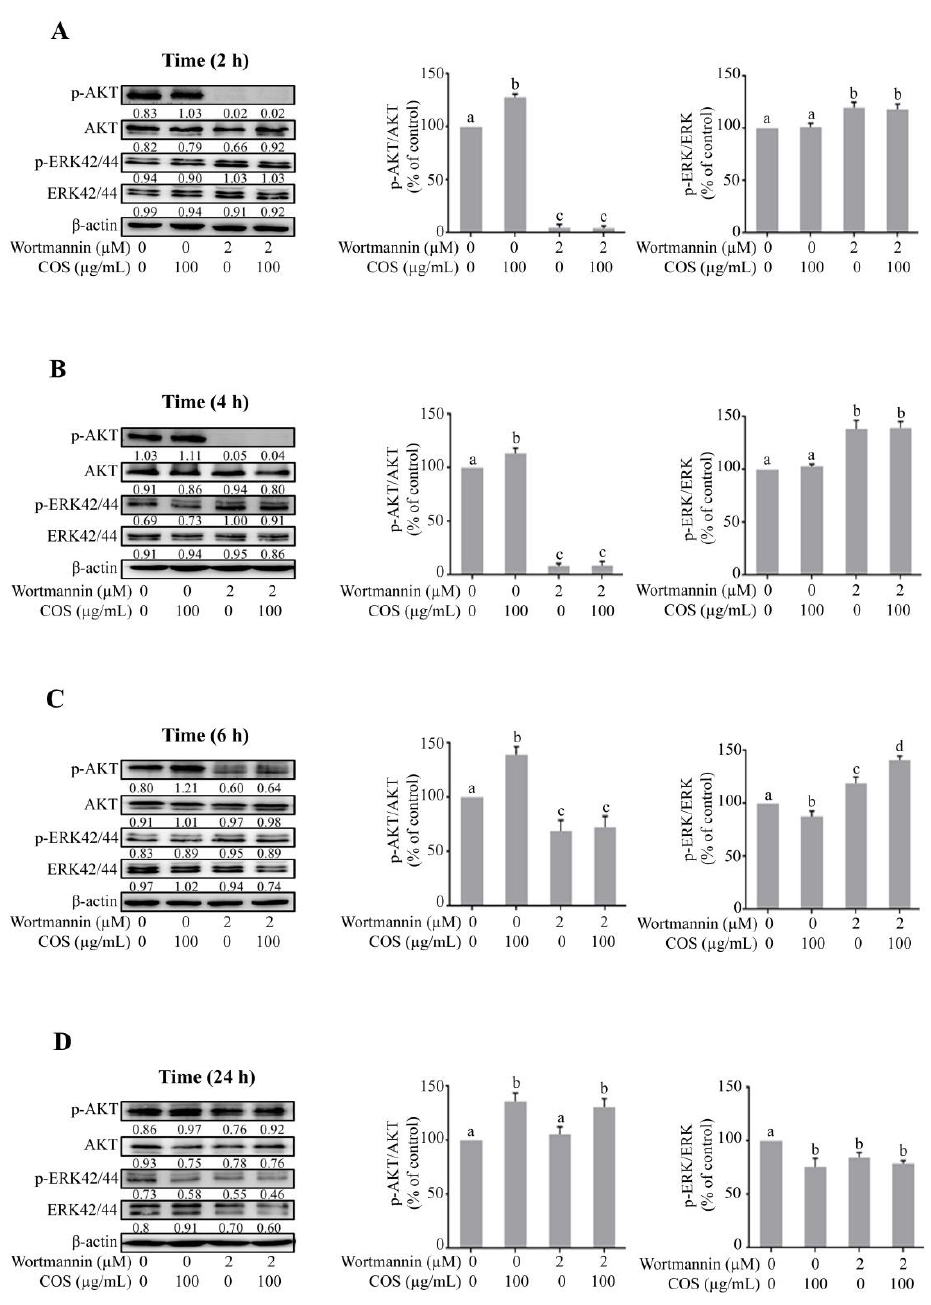
Figure 4. Effect of COS on AKT and ERK phosphorylation studied using wortmannin. ( A ) T84 cells were treated with the indicated concentrations of COS, wortmannin, either alone or in combination for 2 h ( A ), 4 h ( B ), 6 h ( C ), and 24 h ( D ). Data were analyzed as the ratio of p-AKT/AKT, p-ERK/ERK and expressed as % of control (vehicle-treated group), means ± S.D. ( n = 3). Columns not sharing the same superscript letters differ significantly ( p < 0.05, one-way ANOVA Tukey’s post hoc test).